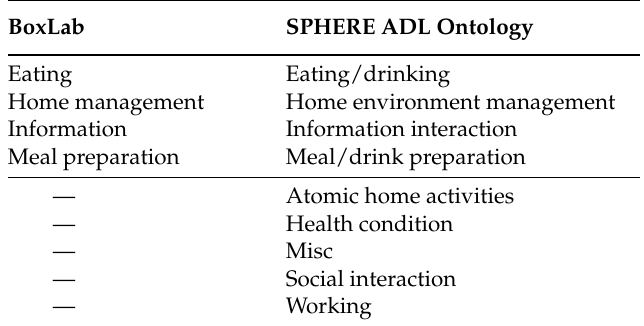
Table 2. New and altered activity